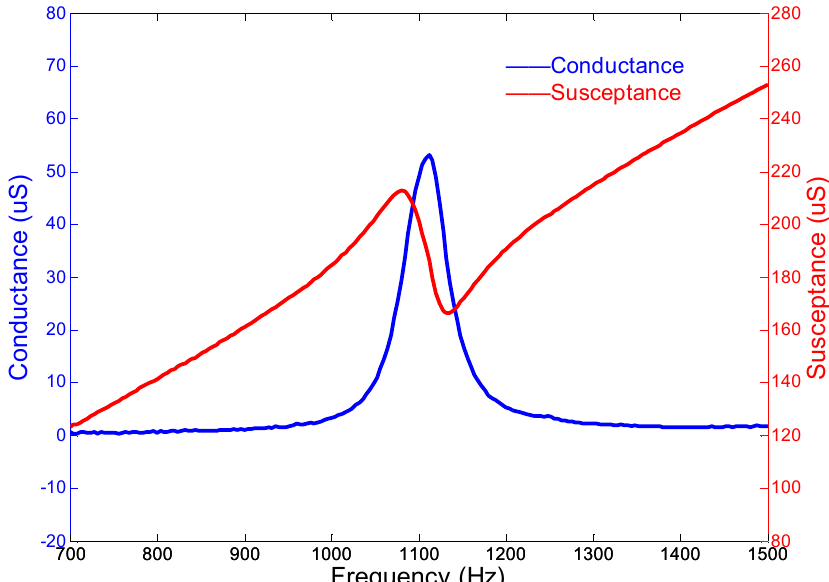
Figure 13. Admittance curves of cascade-connected transducers with ten segments (obtained from Agilent 4294A).